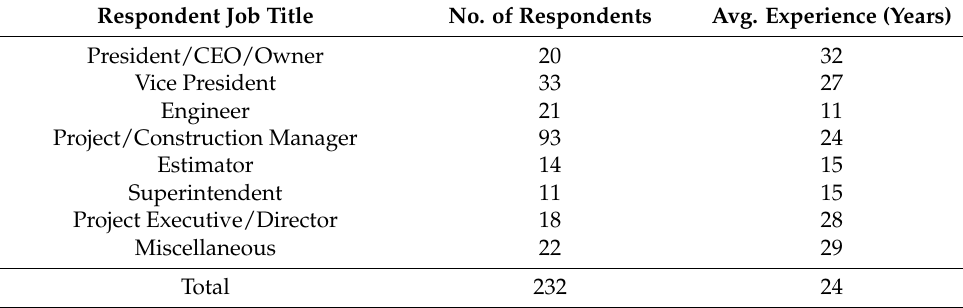
Table 1. Survey Respondents